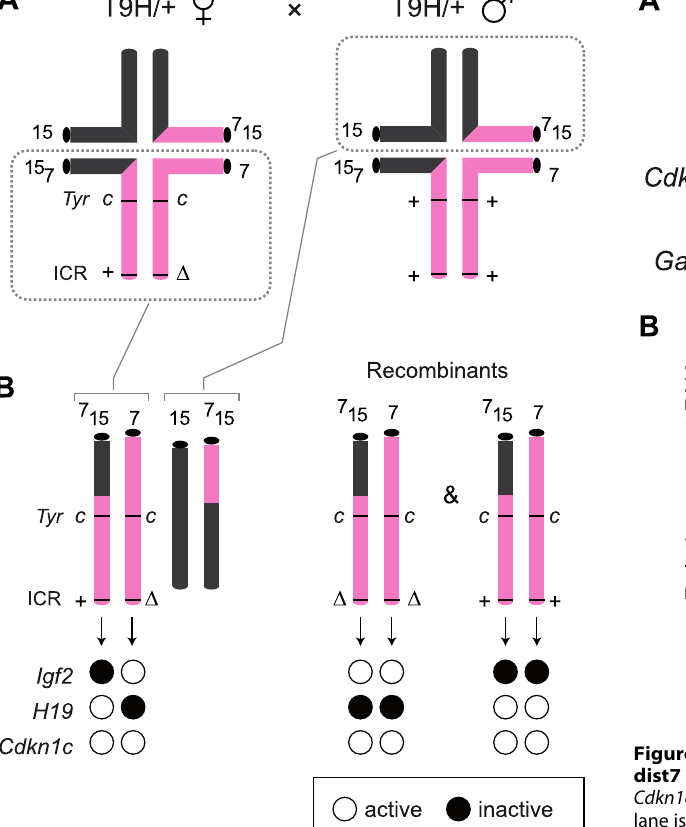
Figure 2. Production of MatDup.dist7 fetuses. (A) Quadrivalents at meiosis I occurring in (T9H/ + , Tyr c / c , ICR D / + R 6 T9H/ + , Tyr + / + , ICR + / + = ) matings. Female reciprocal translocation heterozygote (T9H/ + ) parent is homozygous for the dist7 marker albino ( Tyr c / c ) and carries ICR D (ICR D / + ), while the male T9H/ + parent is wild-type at both of these loci ( Tyr + / + , ICR + / + ). (B) Genotypes of MatDup.dist7 fetuses obtained from the union of unbalanced complementary gametes. MatDup.dist7 individuals are readily identified as albinos from 12 K dpc by lack of eye or fur pigmentation. Many of these are ICR D . + although a high frequency of homozygous recombinants, ICR D . D and ICR + . + , are also obtained. Chrs depicted are actually paired chromatids. Underneath is depicted allele- specific expression—MatDup.dist7 ICR D . + and ICR D . D fetuses have one and probably two activated Igf2 alleles, and should have one and two repressed H19 alleles, respectively.